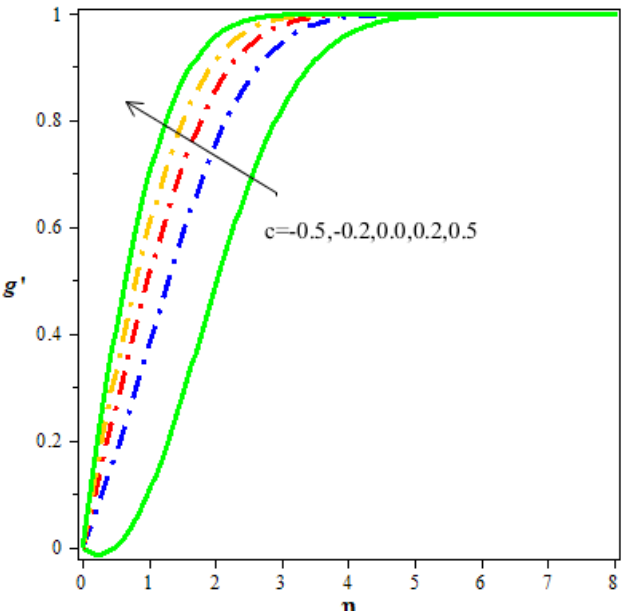
Figure 4. The curve g (cid:48) ( η ) on c .